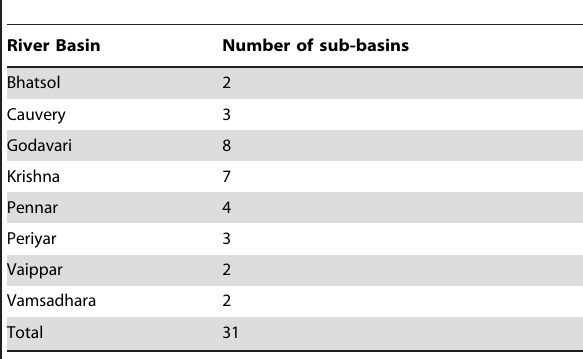
Table 1. Number of sub-basins in each river